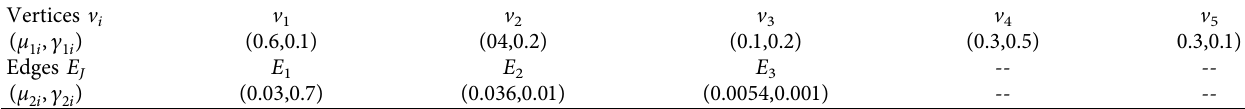
Table 2: Degree of membership and nonmembership values for vertices and edges of Figure